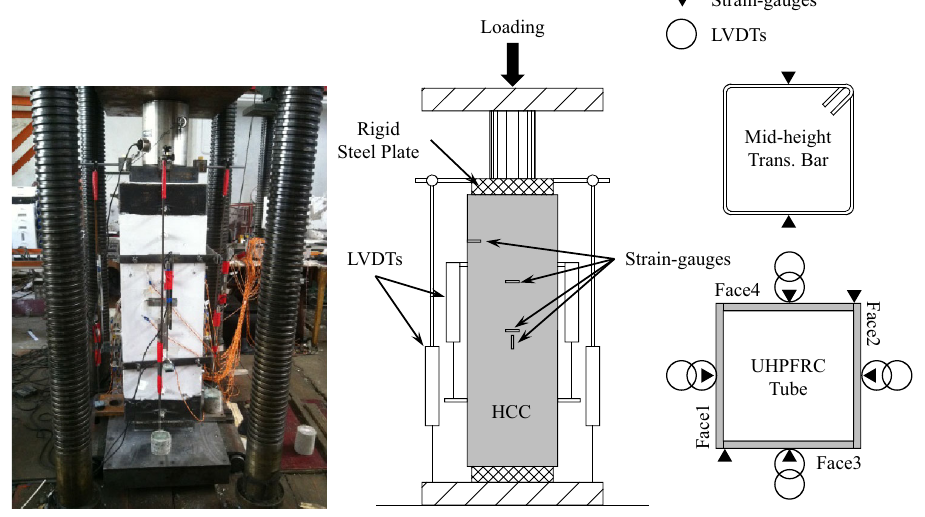
Fig. 5 Test setup and